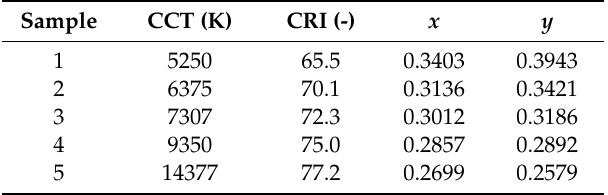
Table 2. CCT and CRI values and color coordinates for samples